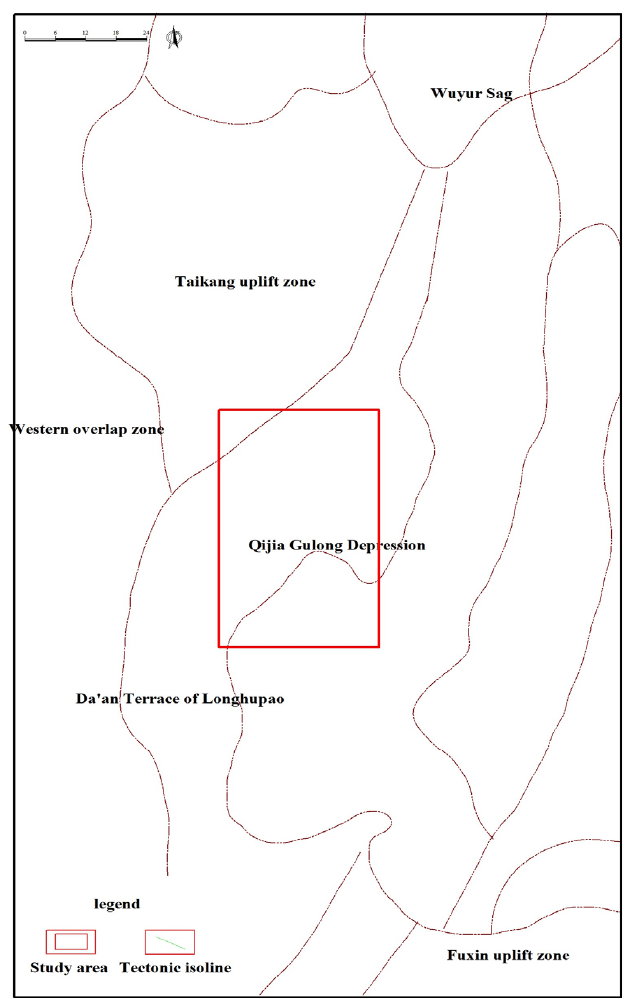
Figure 3. Location map of the Bayan Chagan Area.